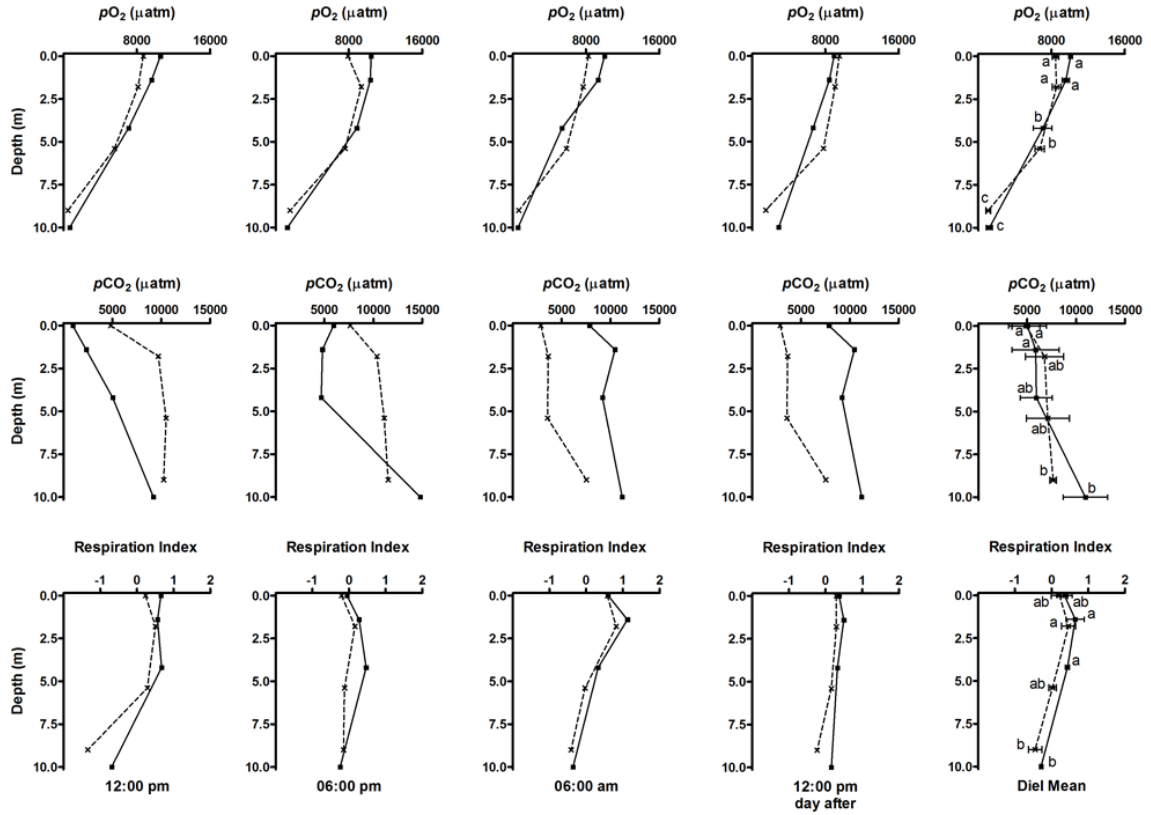
Fig. 6. Vertical profiles of daytime p O 2 , p CO 2 and respiration index from the lake surface to deep waters for both lakes during initial thermal stratification events at the end of the dry season (September 2005). Values are the average ± SE. Symbols and letters are as defined in Fig.